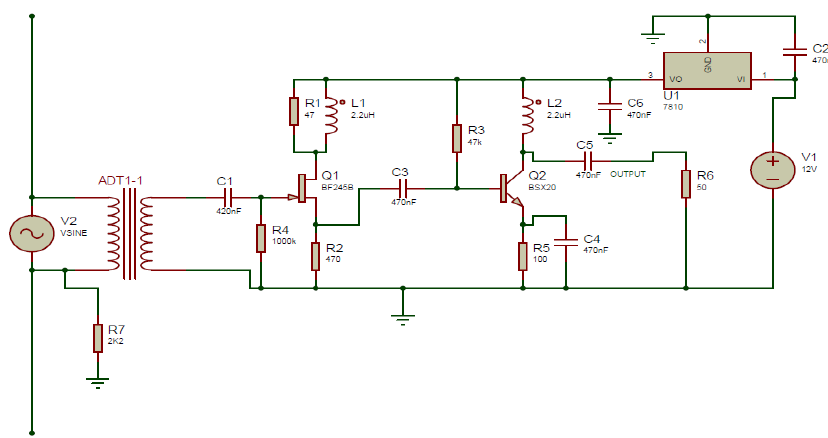
Figure 7. The schematic of the two-stage LNA.